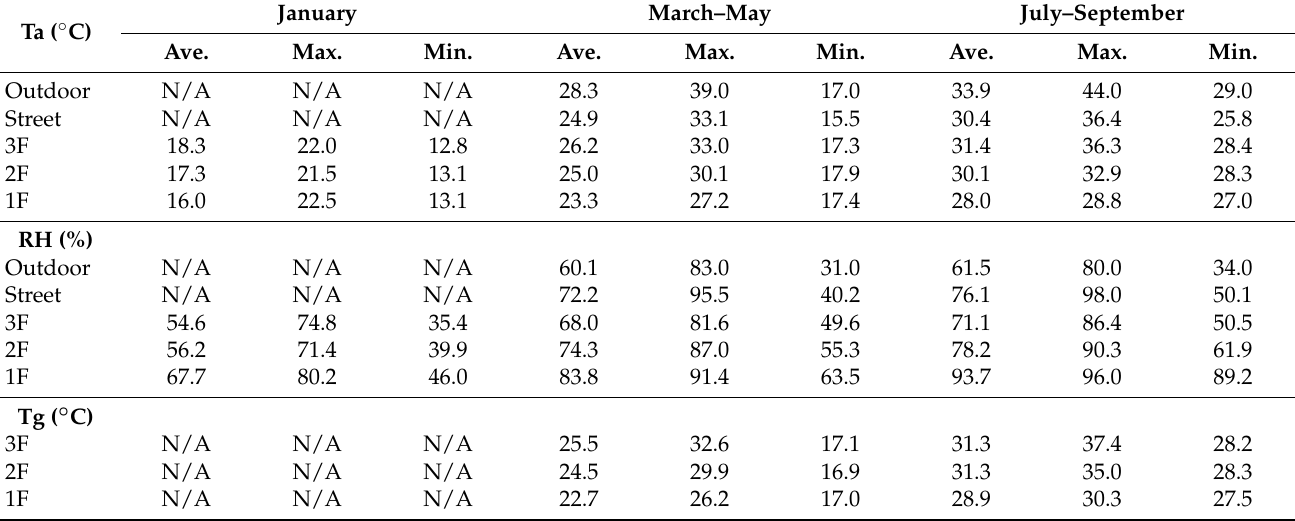
Table 5. Ta, RH, and Tg measurements